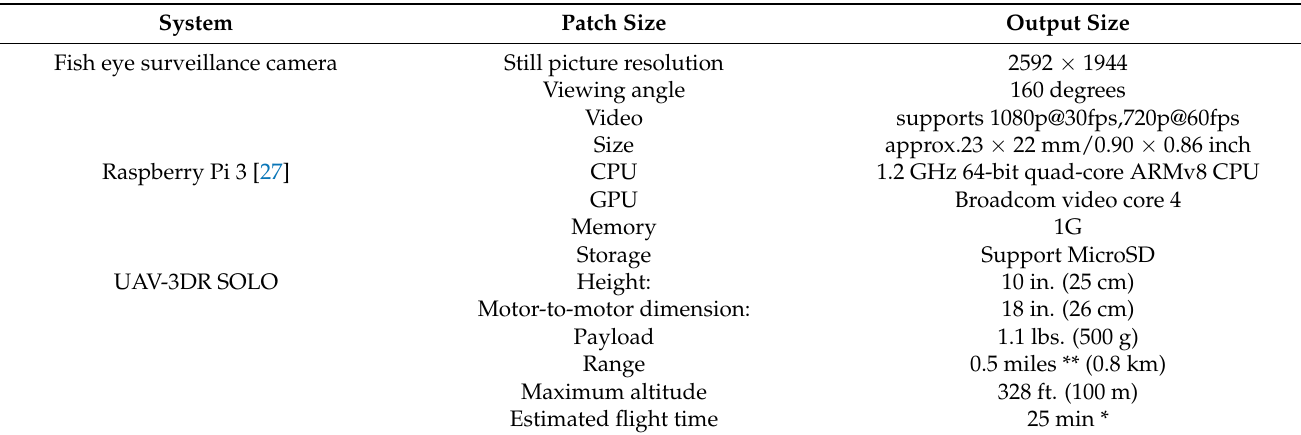
Table 2. Specification of the UAV and camera for testing.